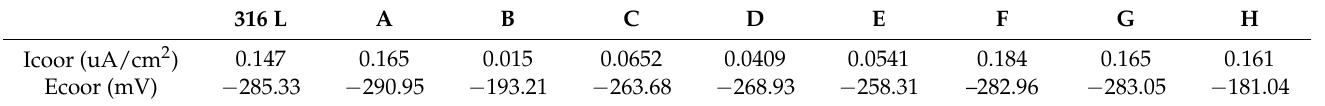
Table 3. Electrochemical parameters in 3.5% NaCl obtained using a curve-fitting